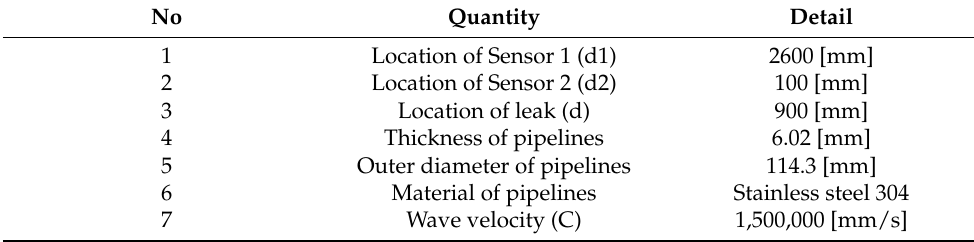
Table 2. Pipeline experiment information.